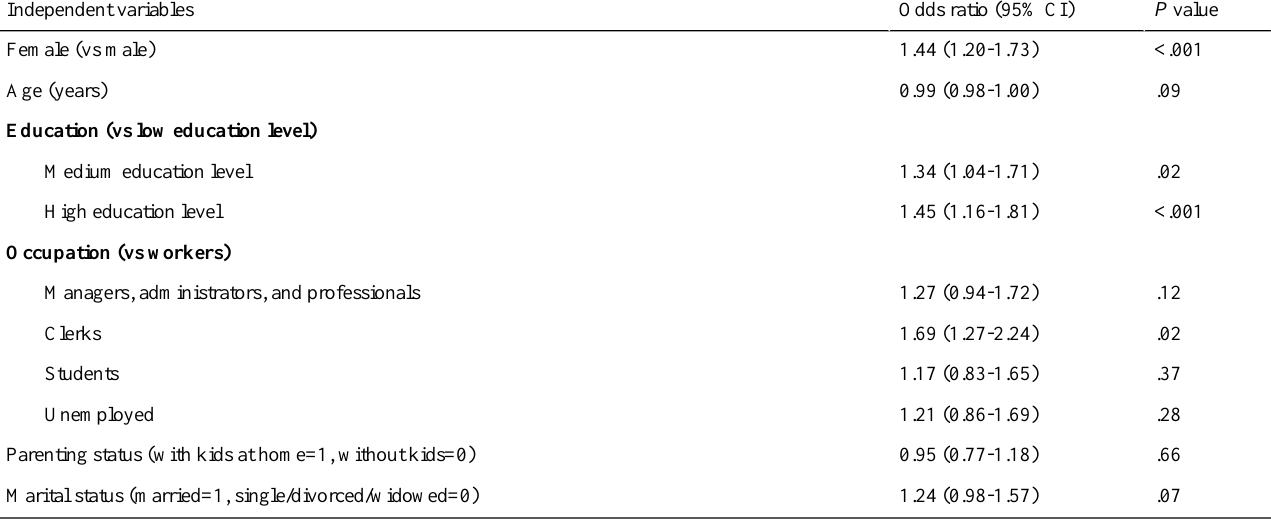
Table 2. Binary logistic regression coefficients predicting the adoption of mobile health apps a